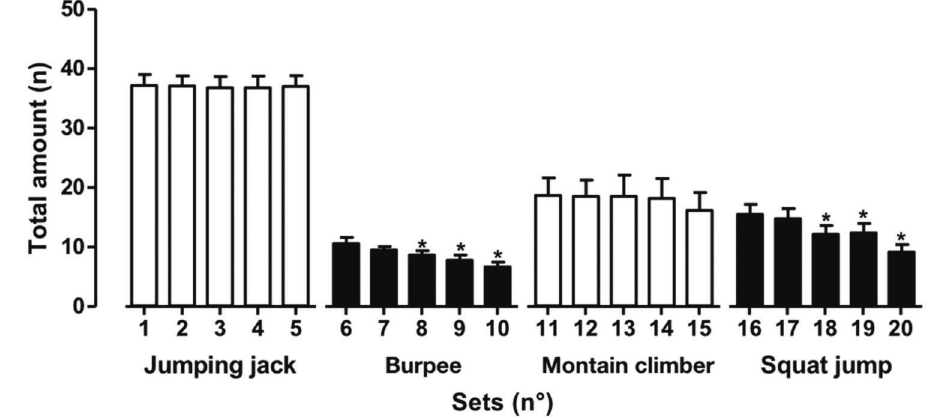
Figure 1 - Values are presented as the means ± standard deviations. * p o 0.01 vs. the first set of each exercise.